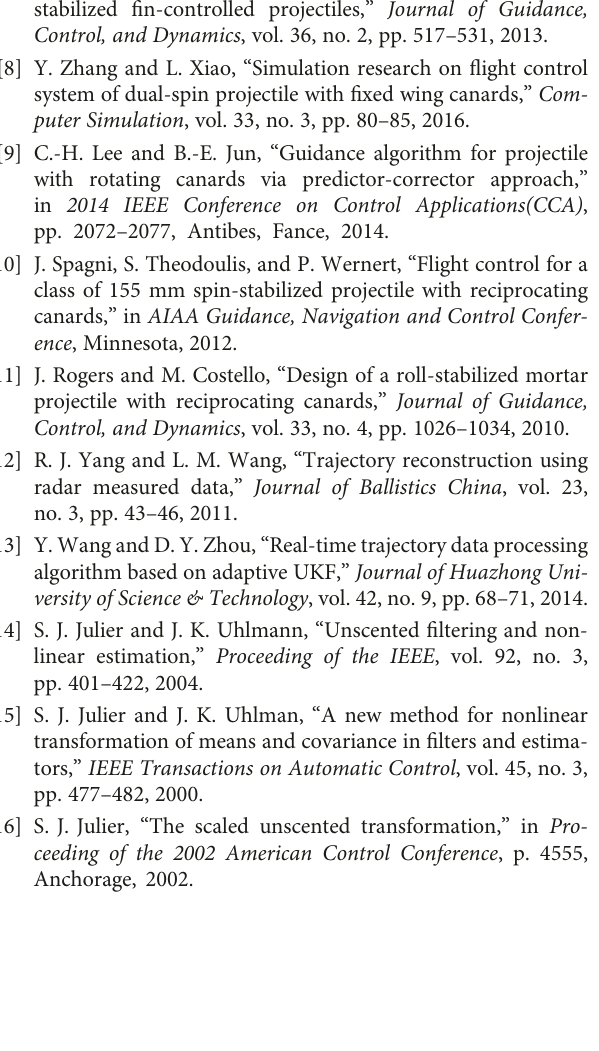
comparison fi e